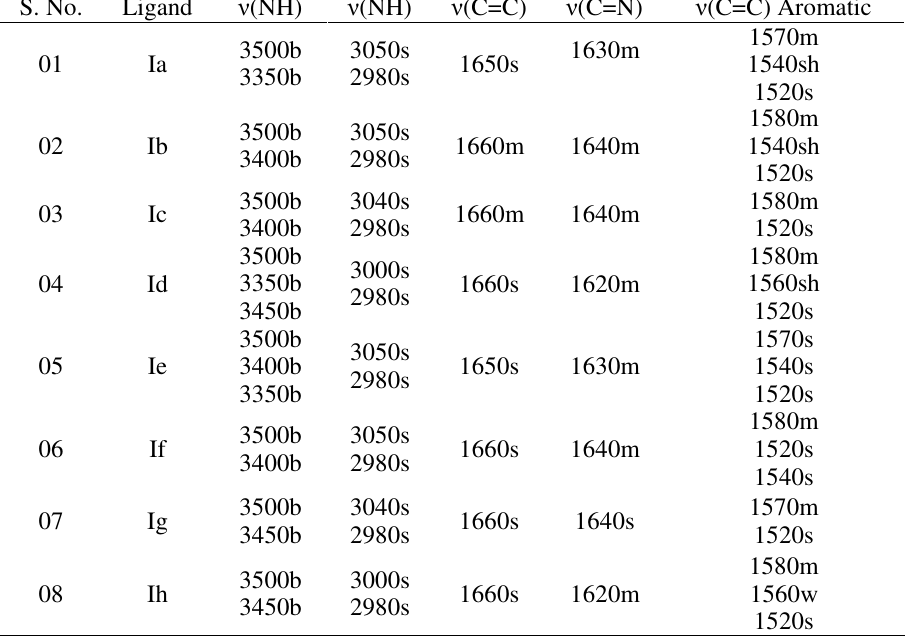
b = broad, s = sharp, m = medium, sh = shoulder, w = weak Table 4. Important infrared frequencies of few representative complexes and their assignments . Complex